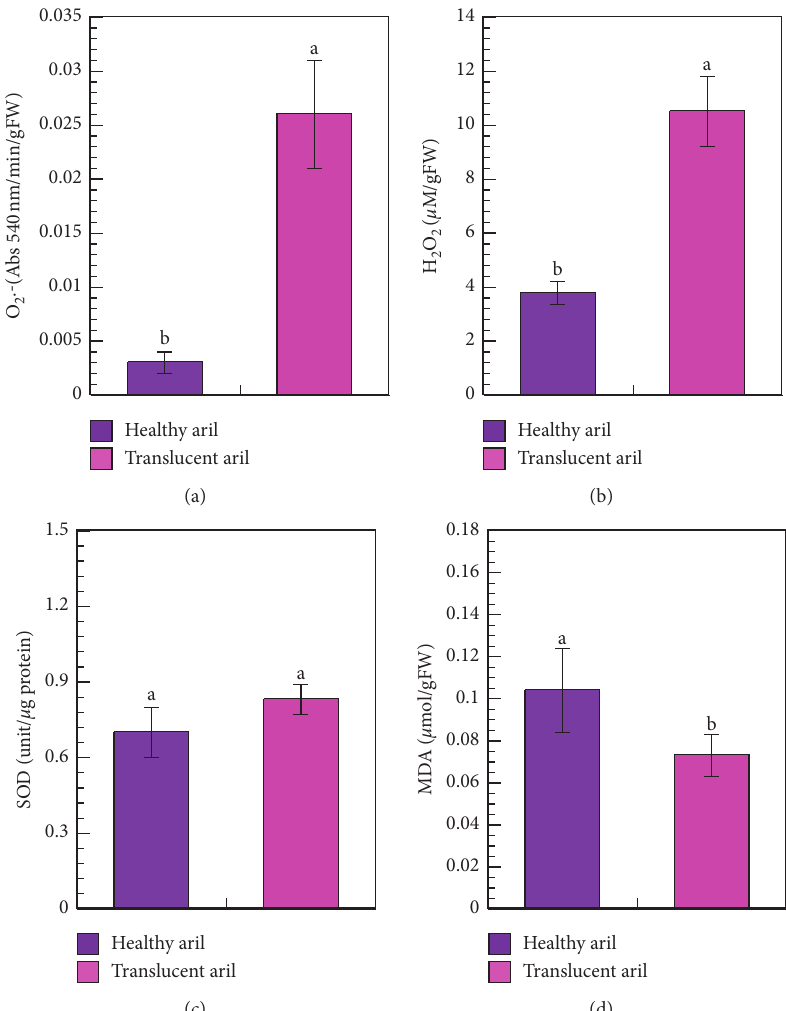
Figure 2: O . − (a), H 2 O 2 content (b), superoxide dismutase activity (c), and malonaldehyde content (d) in healthy and translucent arils. 2 Means ( n � 4) with different lower-case letters on the bars are significantly